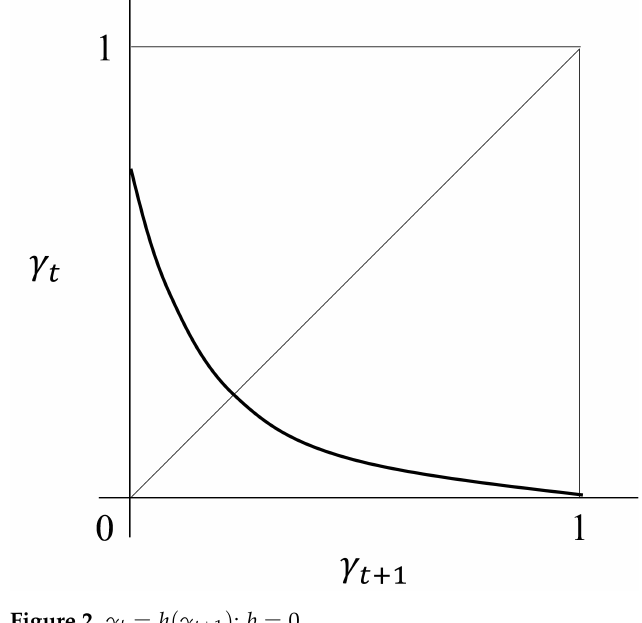
Figure 2. γ t = h ( γ t + 1 ) : b = 0.